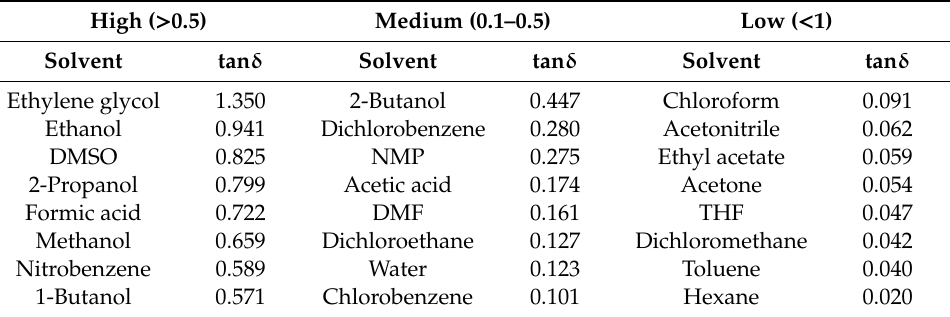
Table 2. tan δ values of di ff erent solvents at 2.45 GHz and 20 ◦ C [428,458,459]. High ( >